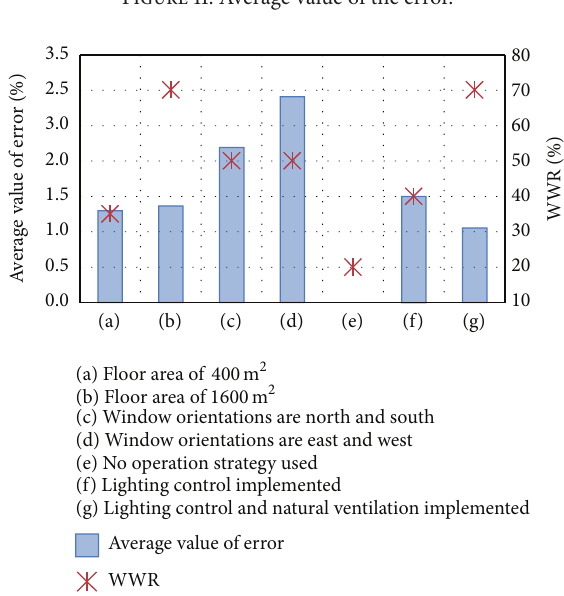
Figure 11: Average value of the error.